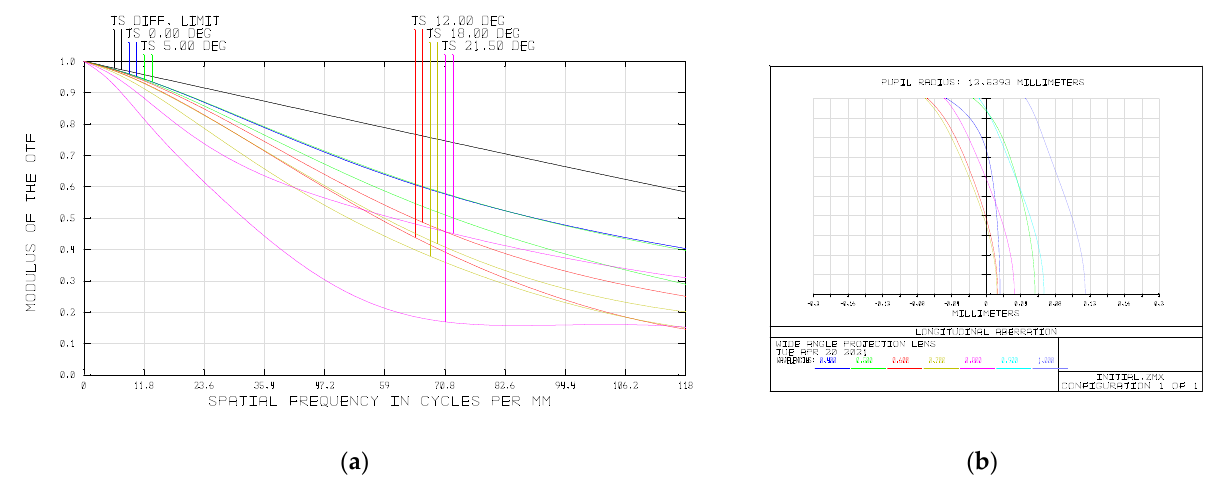
Figure 7. ( a ) MTF; ( b ) longitudinal aberration of the initial system.